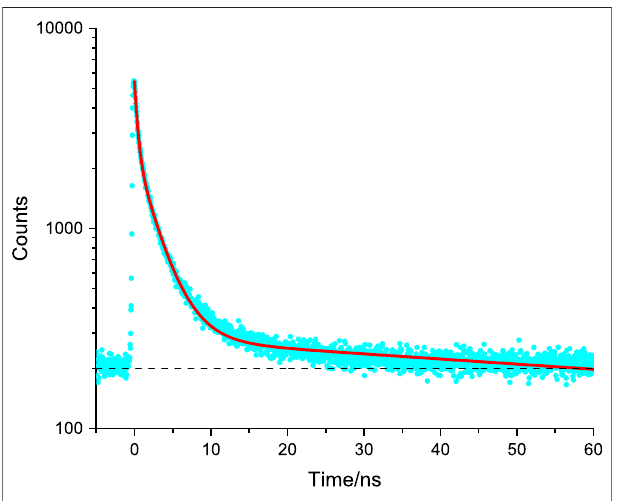
FIGURE 6 | Representative time-resolved fl uorescence microscopy decay of HepG2 internalised liposomal DPTZ-DBO2 used to determine fl uorescence lifetime by fi ttingthedata(green dots)toacurve(redlinethrough least-squares fi tting procedures. Dashed black line indicates a baseline intensity. See text for details and Table 1 for